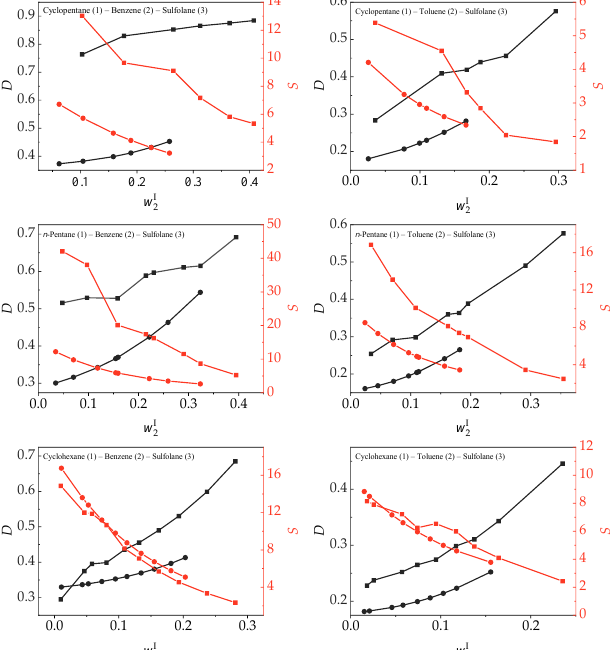
Figure 4. The distribution coefficients ( D ) and separation factors ( S ) of benzene and toluene (mass fraction) in the extracted phase (I). ( ■ ) Experimental or reference [29–31] data; (●) calculated data using the COSMO-RS model.